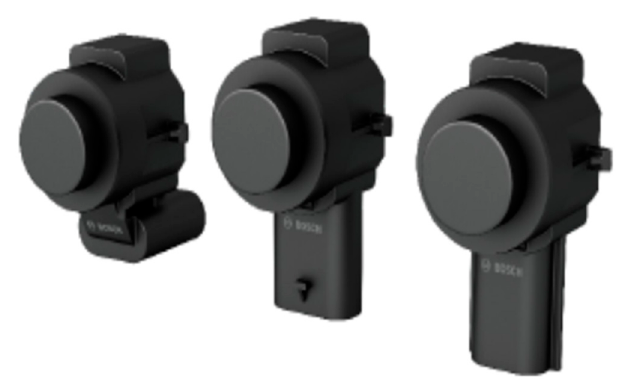
Figure 6. Ultrasonic surround sensor from Bosch [126].